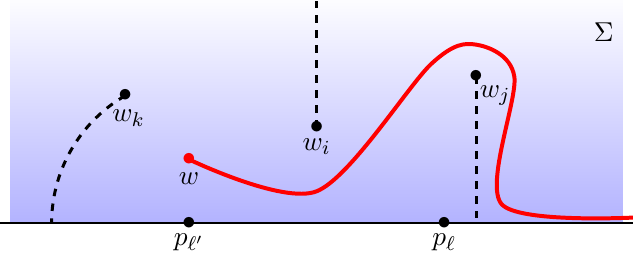
Figure 1 . Branch cuts for F are drawn as black dashed lines and do not intersect each other or poles on the real line. The cuts shown correspond to (cid:13) i = (cid:0) 1, (cid:13) j = 1 and (cid:13) k = e i(cid:25)= 3 . An integration contour for I , which does not intersect any of the branch cuts, is shown in